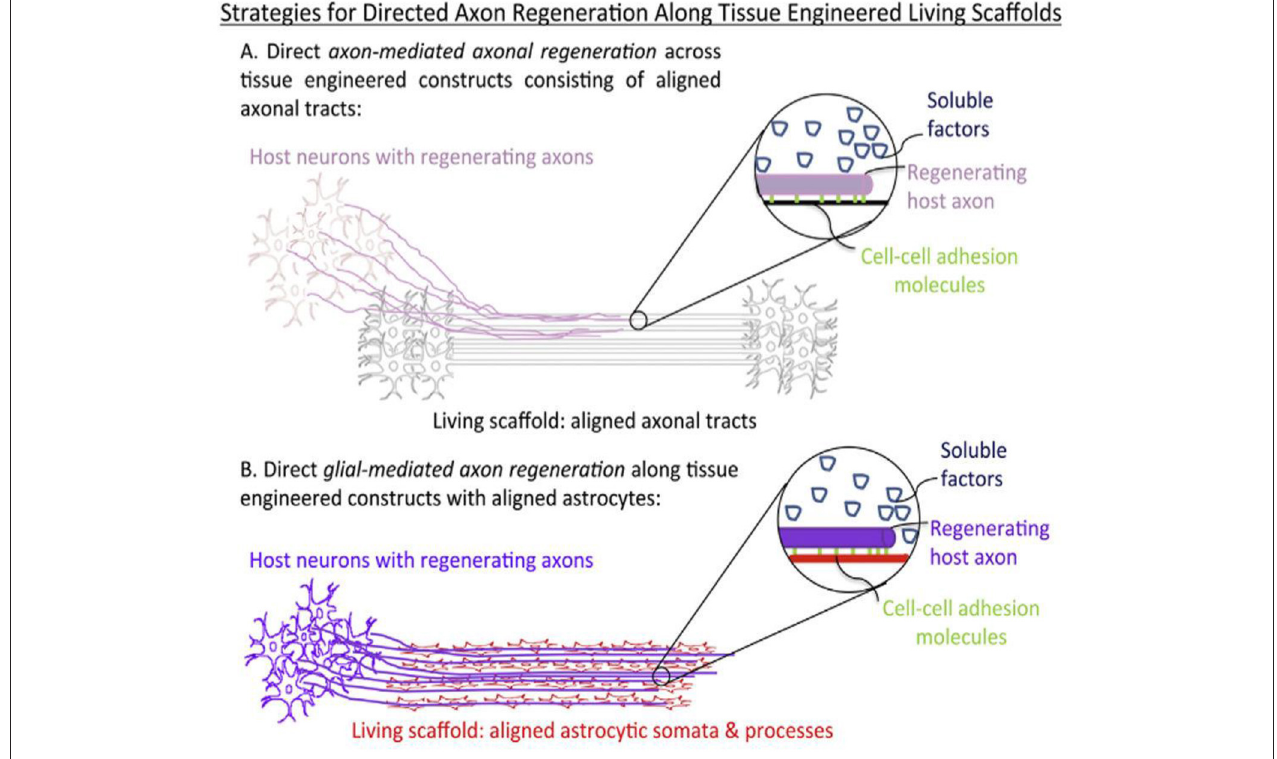
FIGURE 9 | Structural and soluble cues directing axonal outgrowth along “living scaffolds” (Struzyna et al., 2014) Copyright 2014,